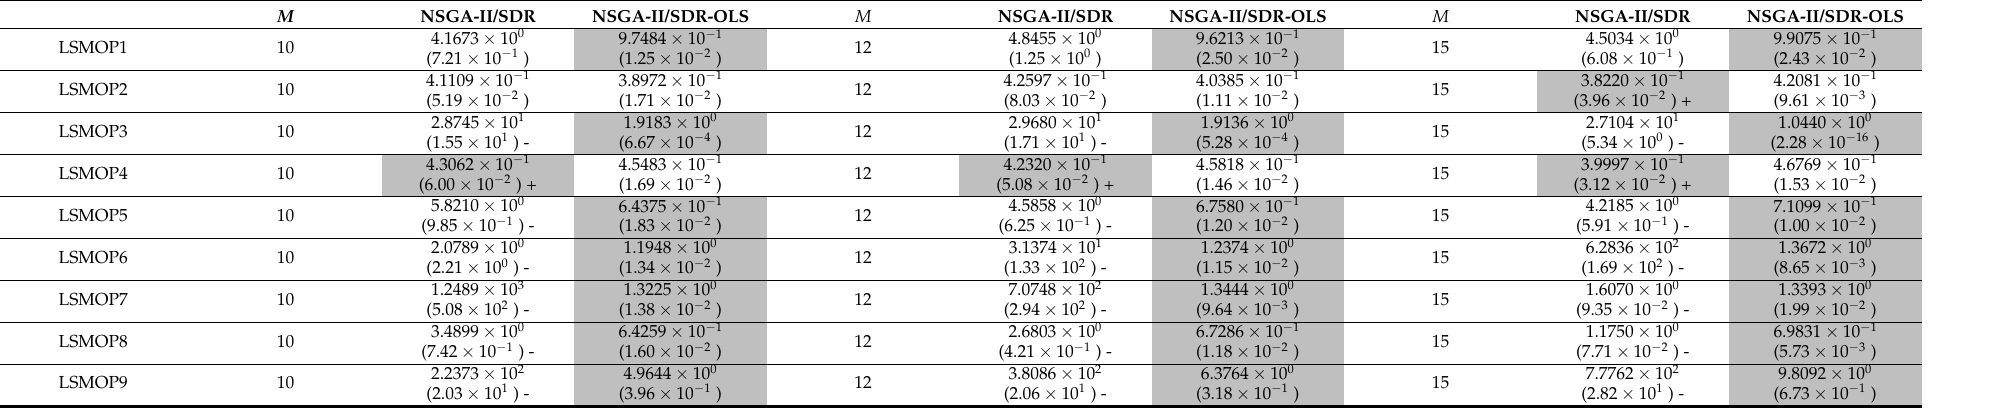
The gray background represents that this algorithm has the best performance on this problem. The number in the brackets represents the standard deviation of IGD values, and the number out of the brackets represents the mean of IGD values. “+/-/=” means that the relevant algorithm performs better than/worse than/as well as the NSGA-II/SDR-OLS algorithm in terms of IGD